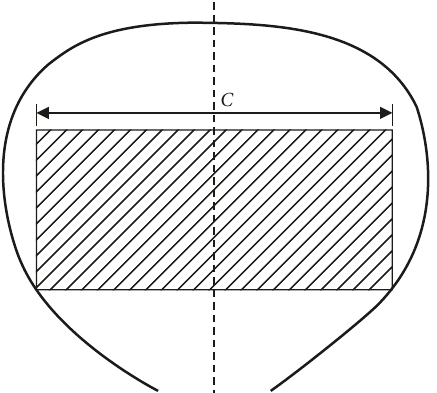
Figure 7: Lifting of an object, considering the normal force and the static friction force at the contact point of the soft